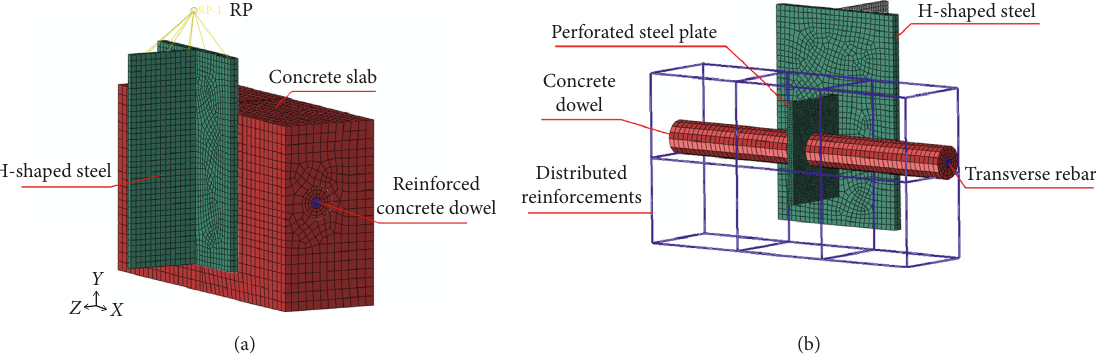
Figure 8: FE model: (a) half of the push-out specimen; (b) components.